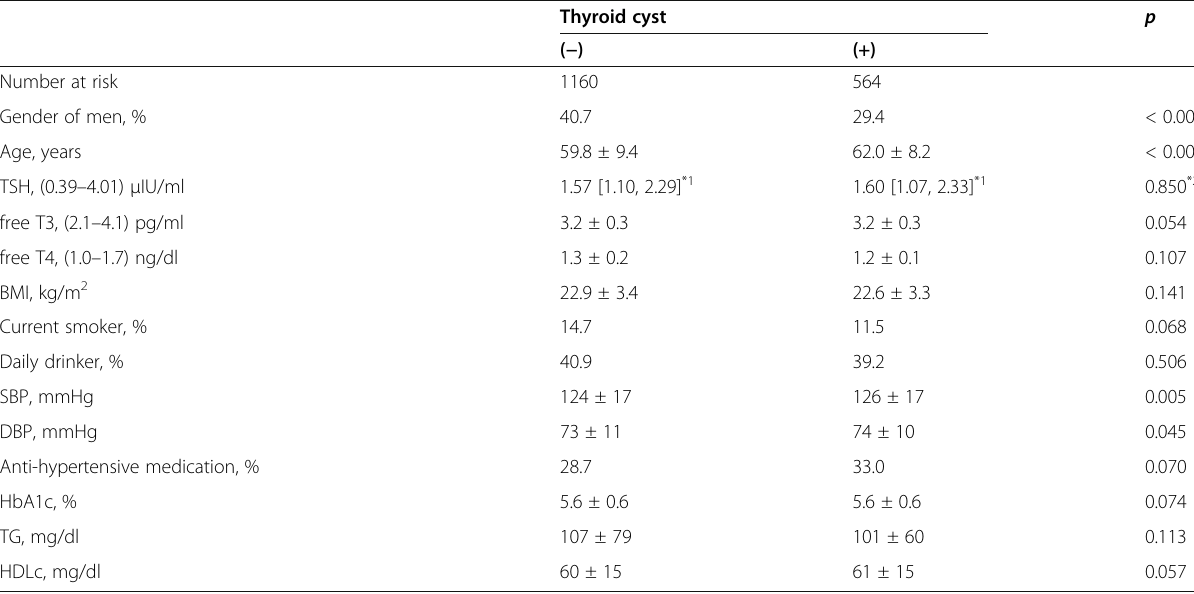
Table 1 Characteristics of study